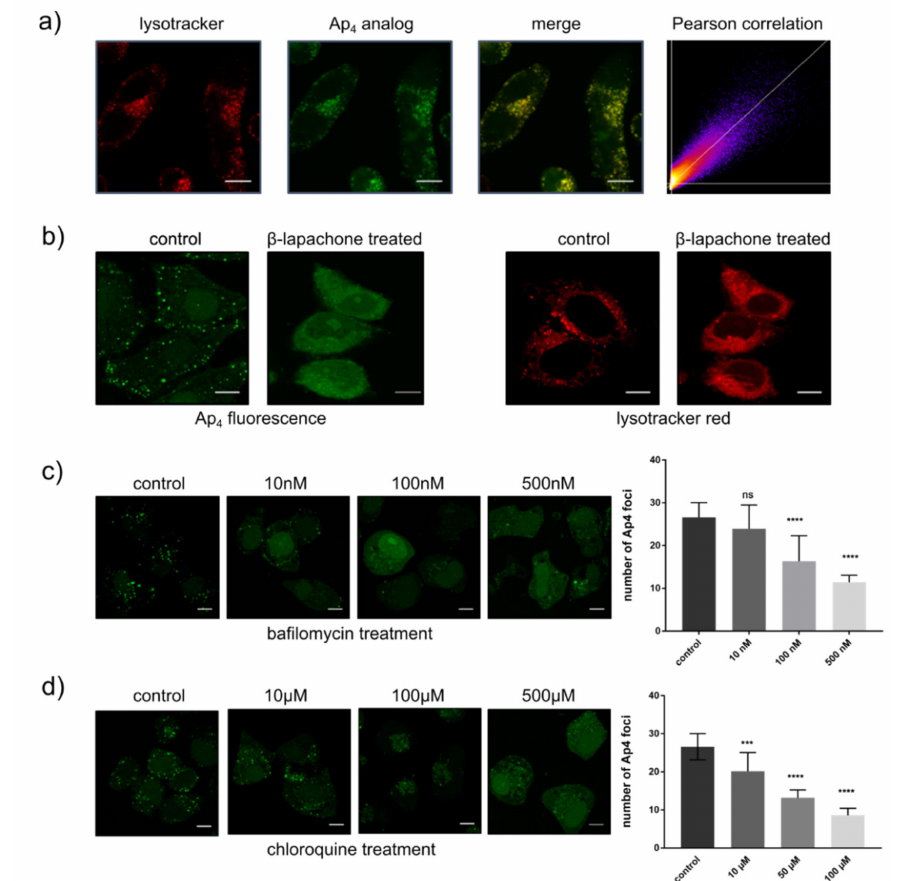
Figure 5. Colocalization of the Ap4 analog with lysosomes and te heffect of β -lapachone on integrity lysozomes and Ap4 analog hydrolysis. ( a ) HeLa cells were treated with lysotracker ( red ) and Ap4 analog ( green ). Colocalization of both compounds is shown in yellow. A scatterplot of red and green pixel intensities is shown. The average Pearson’s correlation coefficient for 10 cells is 0.91 (SD = 0.015). Scale bar: 10 µ m. ( b ) Fluorescence images showing the intensity distribution of the Ap4 analog and lysotracker before and after the treatment of cells with β -lapachone. Effect of bafilomycin ( c ) and chloroquine ( d ) on Ap4 hydrolysis. Statistical significance compared with the control. Ordinary one-way ANOVA *** p < 0.001, **** p < 0.0001; ns: not significant. Scale Bar: 10 µ